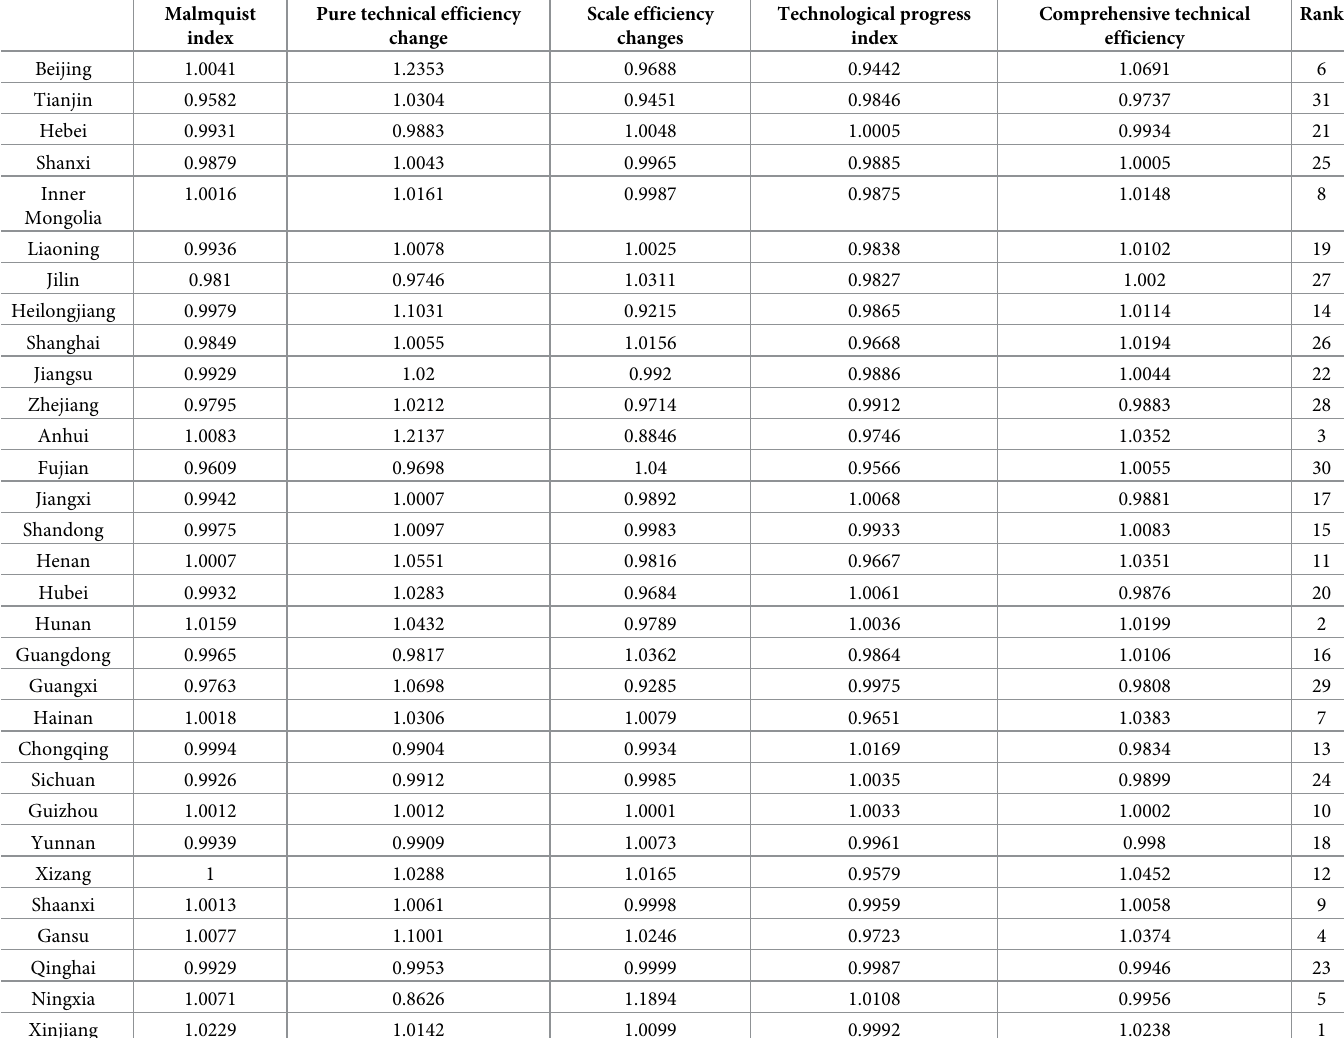
Table 5. Malmquist index of each province and its